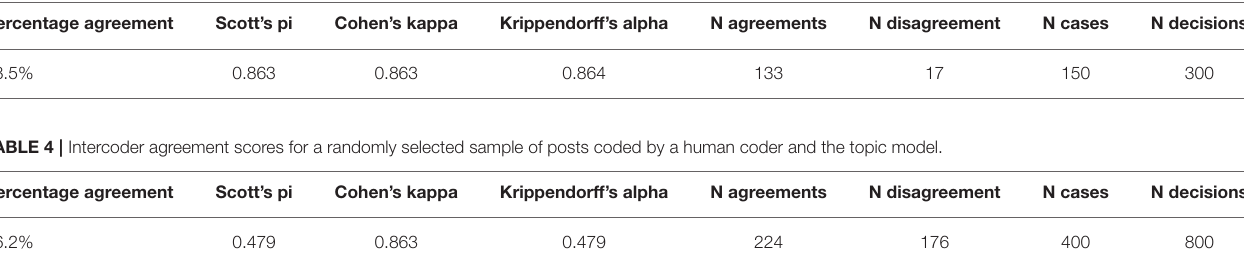
TABLE 3 | Intercoder agreement scores for a randomly selected sample of posts coded by two human coders. Percentage agreement Scott’s pi Cohen’s kappa Krippendorff’s alpha N agreements N disagreement N cases N decisions 88.5% 300